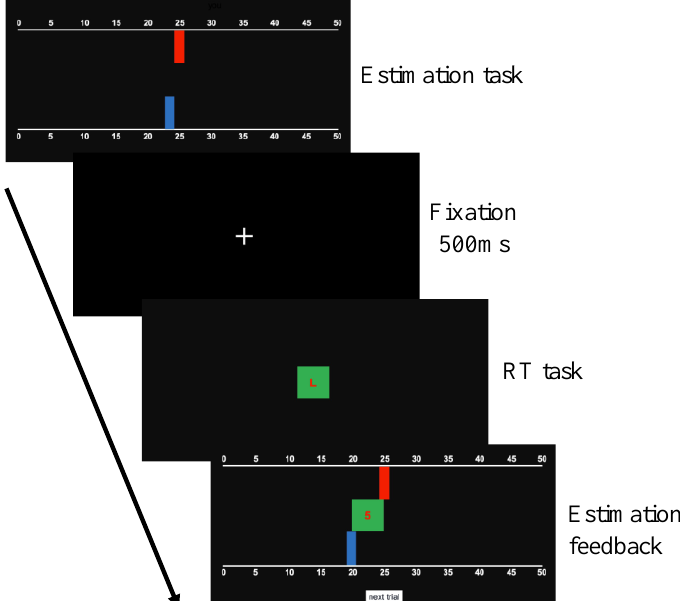
Figure 1. Schematized trial of the estimation task and RT (reaction time) task. First, participants make an estimation (red) by clicking the graduated estimation line. Second, the fixation was shown and lasted for 500 ms. Third, the prediction error (the green rectangle) was shown and one letter (“L” or “R”) was printed on the rectangle. Participants were informed about pressing the left mouse button if the letter is “L” and pressing the right mouse button if the letter is “R” as quickly as possible. After the RT task, the current estimation (the red bar), the newly generated target value (the blue bar), and the prediction error made in the estimation task (the green rectangle) were shown.